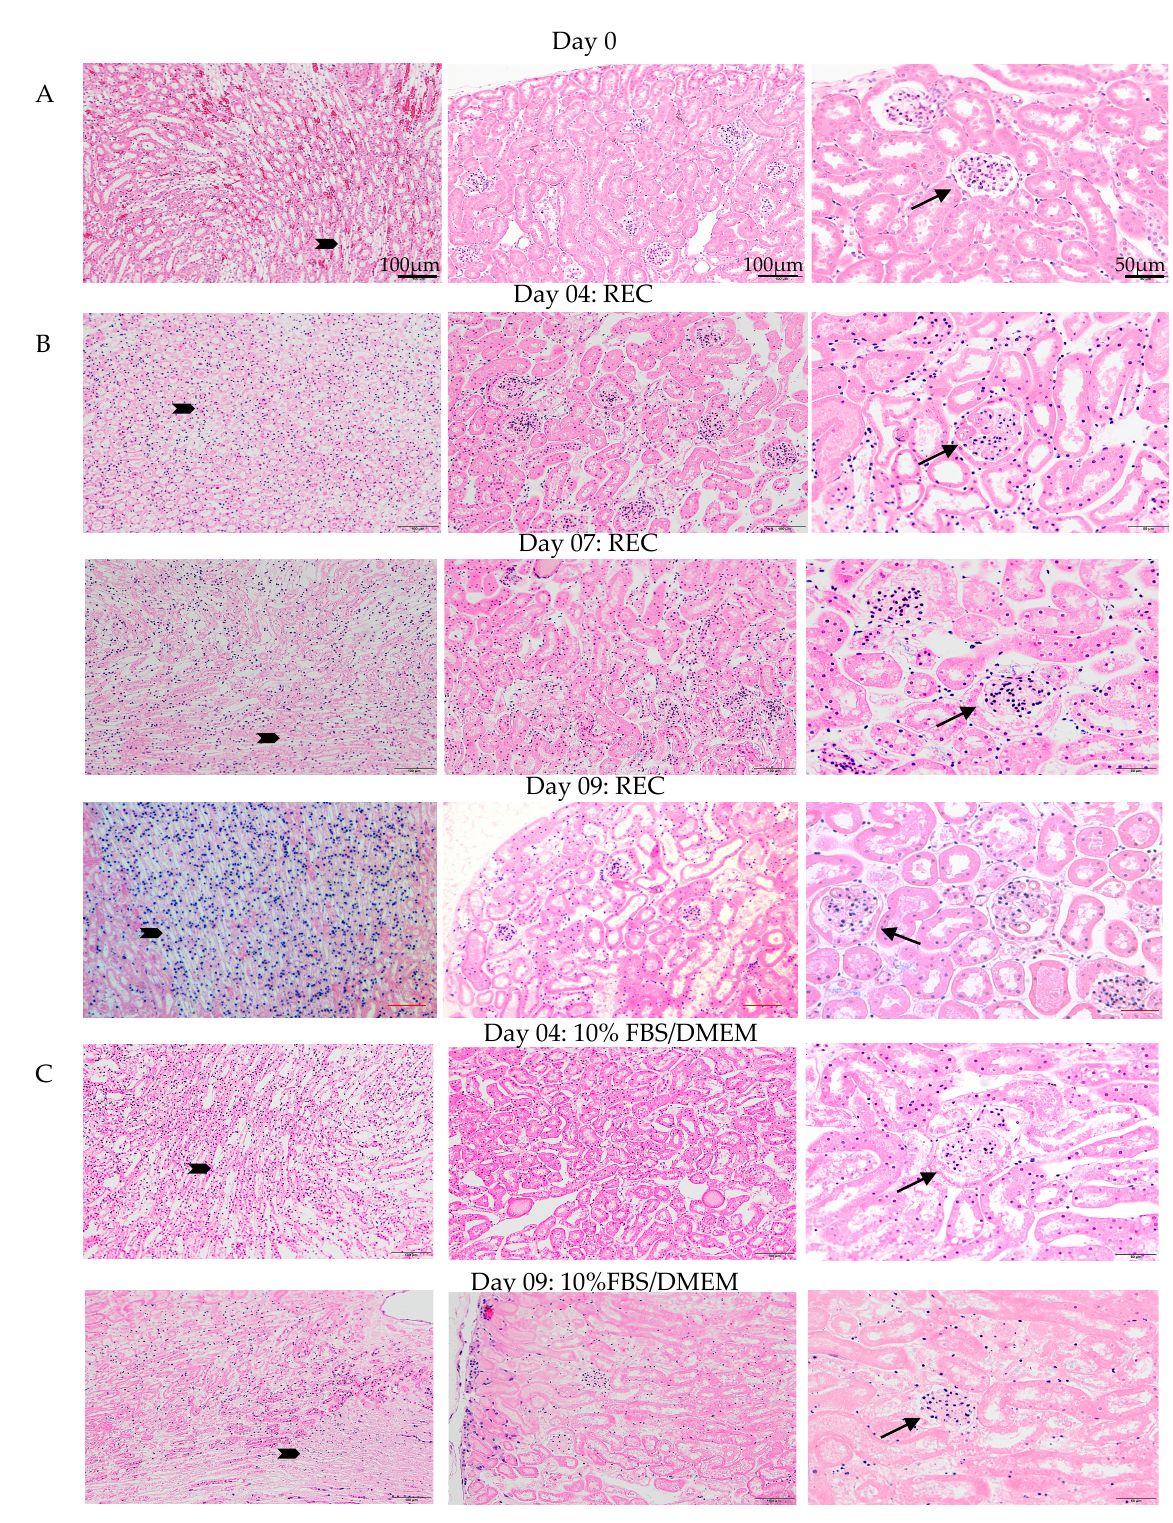
Figure 3. Kidney pathology post ex vivo perfusion. ( A ) Control kidney, cannulated but not perfused. ( B ) Kidneys perfused with Renal Epithelial Medium for 4, 7, 9 days have similar pathology and intact nuclei to control kidneys. ( C ) Kidneys perfused with 10% DMEM medium for 4, 9 days. Day 4 have healthy pathology but some degradation with weak nuclei staining at day 9. Arrows indicate glomeruli and block arrows indicate collecting ducts. Bar = 100 µm for first two columns and 50 µm for last column. Representative bar in top row.